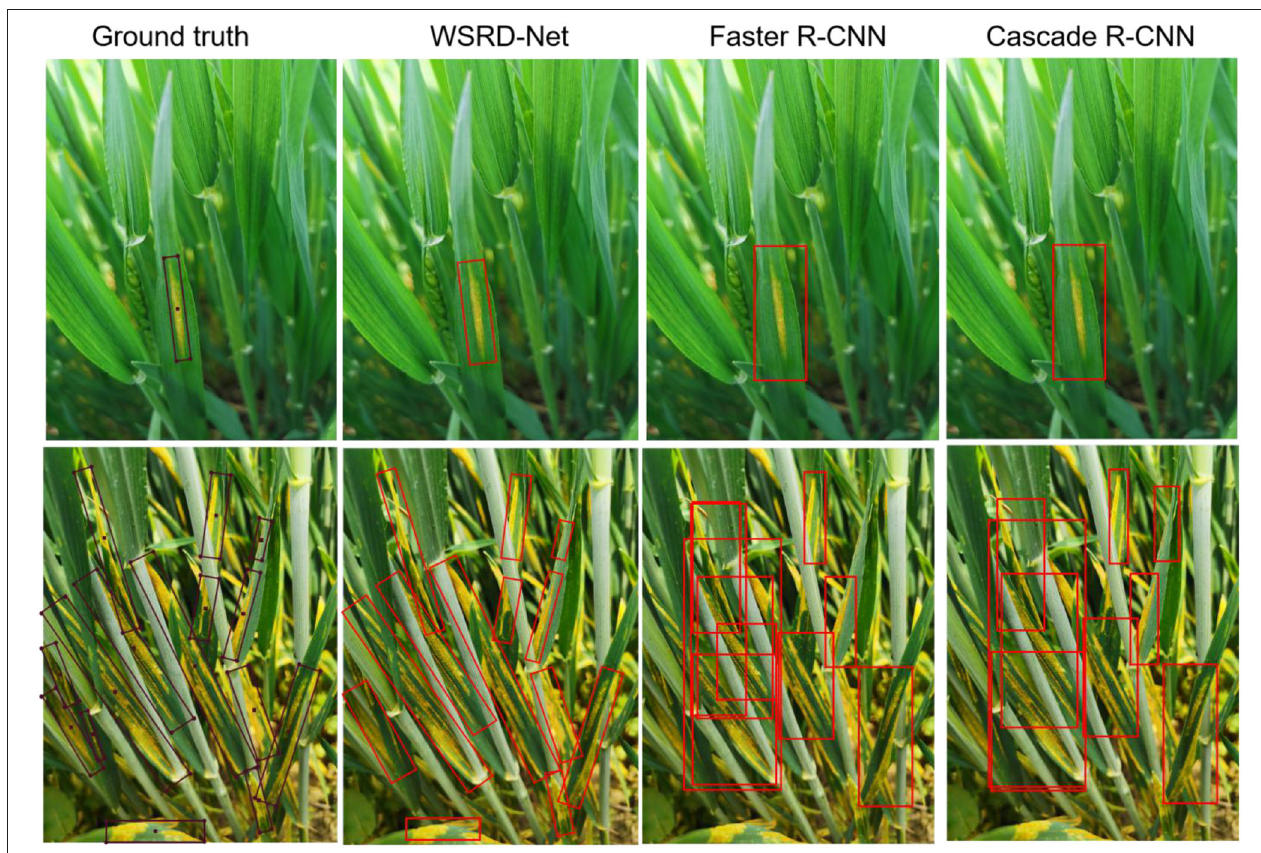
FIGURE 14 | Visualization of the comparison results with horizontal detection models.